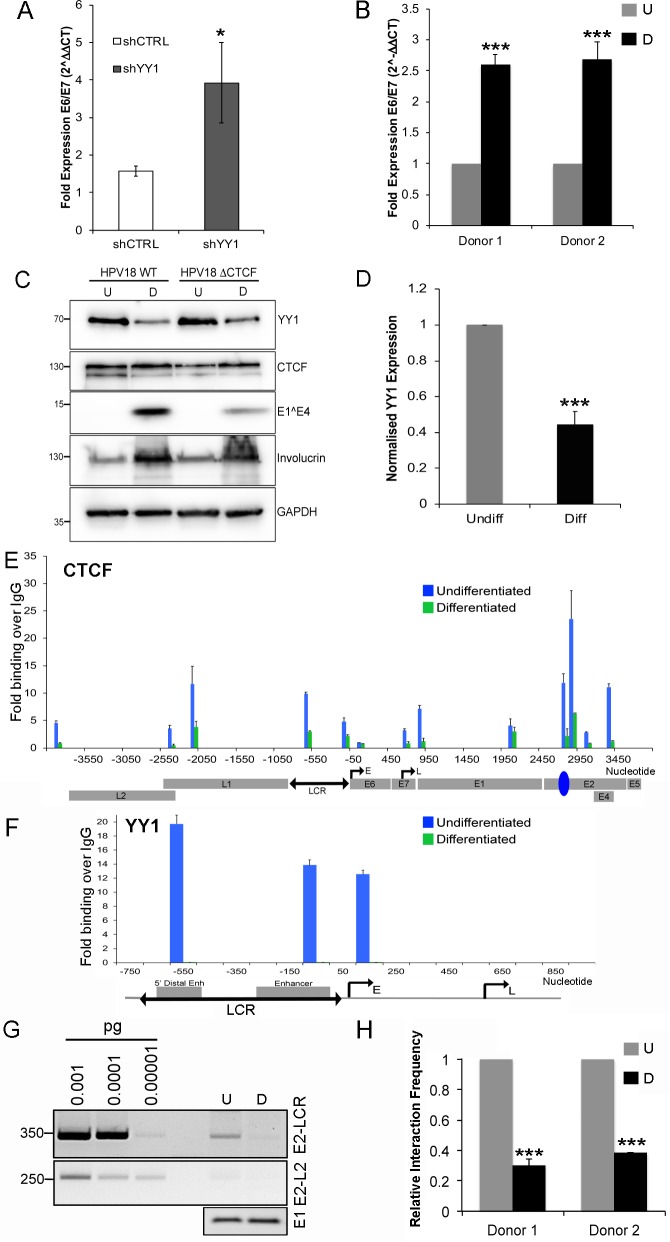
Host cell differentiation controls E2–LCR intrachromosomal interactions through repression of YY1 protein expression.(A) Fold expression change of E6/E7 encoding transcripts was determined by qRT-PCR following shYY1 normalised to β-actin and compared to shCNT. Data show mean ± SEM of three independent experiments performed in triplicate. (B) Fold expression of E6/E7 encoding transcripts after methylcellulose-induced keratinocyte differentiation was determined by qRT-PCR. Data show mean ± SEM in two keratinocyte donors normalised to β-actin and compared to undifferentiated cells. (C) YY1 protein expression in undifferentiated and differentiated HPV18 WT and ΔCTCF HFKs was assessed by western blotting. Involucrin and HPV18 E1^E4 expression was analysed as markers of differentiation. (D) YY1 protein expression was quantified and normalised to GAPDH. Data show normalised YY1 expression relative to undifferentiated cells in four independent experiments ± SEM. CTCF (E) and YY1 (F) recruitment in undifferentiated and differentiated cells were assessed by ChIP-qPCR. Data are represented as mean ± SD. (G) E2–LCR interactions were determined by 3C analysis in undifferentiated and differentiated keratinocytes. The top panel shows amplification of E2–LCR ligation products, and the middle panel shows amplification of E2–L2 ligation products. Lower panel shows E1 ORF amplification. (H) E2–LCR interactions in HPV18 WT genomes were quantified in multiple experimental repeats in each of two independent donors following cellular differentiation. Data are shown as mean ± SEM. **p < 0.01, ***p < 0.001 in all experiments. All raw quantitative data are enclosed in S1 Data. ChIP-qPCR, chromatin immunoprecipitation followed by quantitative PCR; CTCF, CCCTC-binding factor; D, differentiated; E, early promoter; GAPDH, Glyceraldehyde-3-phosphate dehydrogenase; HFK, human foreskin keratinocyte; HPV, human papillomavirus; IgG, immunoglobulin G; L, late promoter; LCR, long control region; ORF, open reading frame; qRT-PCR, quantitative reverse transcriptase PCR; SEM, standard error of the mean; shCNT, nontargeting shRNA control; shRNA, short hairpin RNA; shYY1, shRNA depletion of YY1; U, undifferentiated; WT, wild-type; YY1, Yin Yang 1; 3C, chromosome conformation capture.